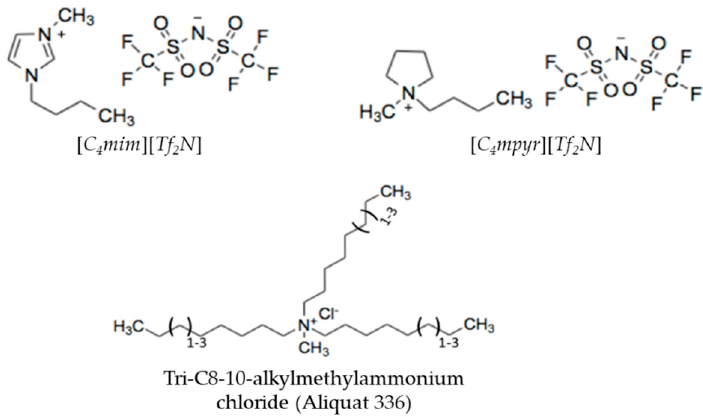
Figure 3. Chemical structures of [ C 4 mim ][ Tf 2 N ], [ C 4 mpyr ][ Tf 2 N ], and